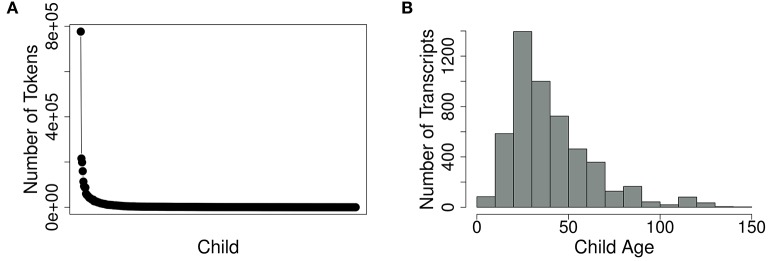
Rank distribution of the number of tokens uttered by each child (A) and distribution of transcripts by child age in months (B).